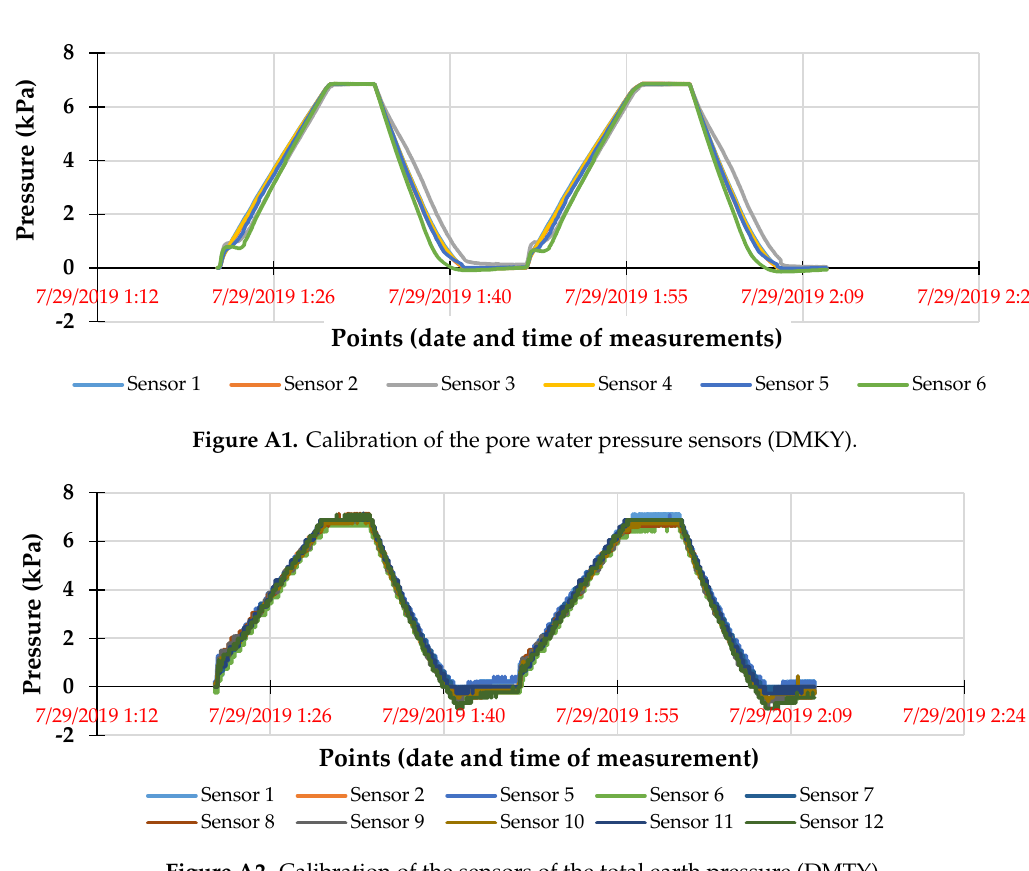
Figure A2. Calibration of the sensors of the total earth pressure (DMTY).